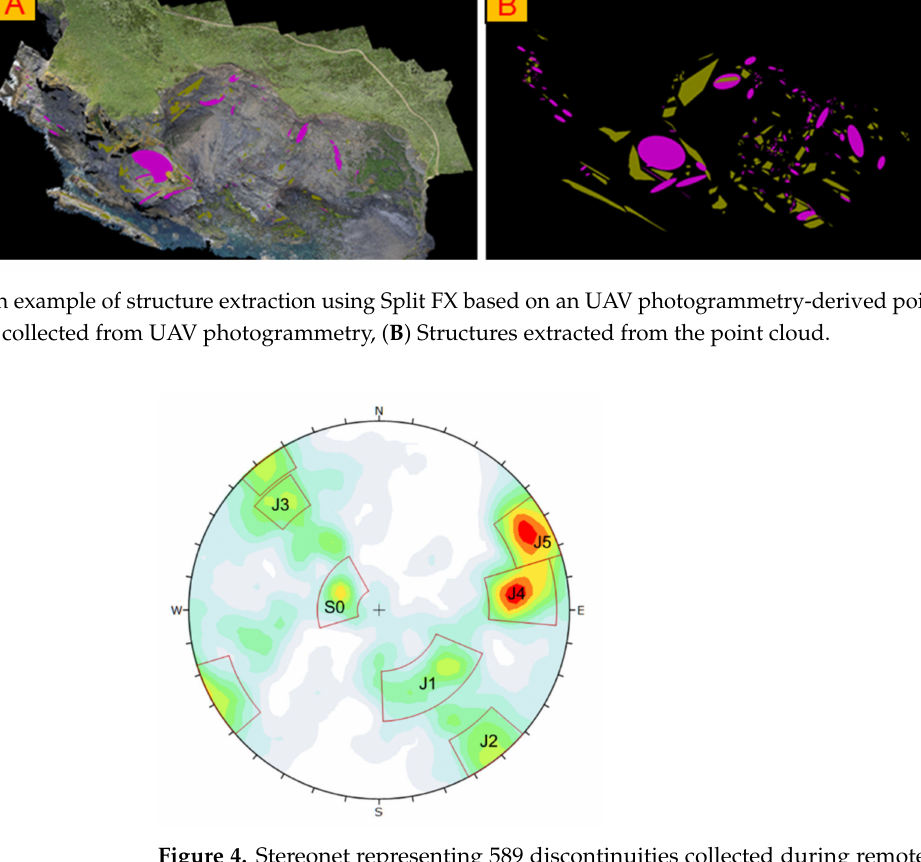
Figure 4. Stereonet representing 589 discontinuities collected during remote sensing surveys of a representative section of coast within the study area (Table 1). Table 1. Properties of six discontinuity sets identified through remote sensing surveys, including dip angle, dip direction, and some descriptions associated with the surface conditions obtained from